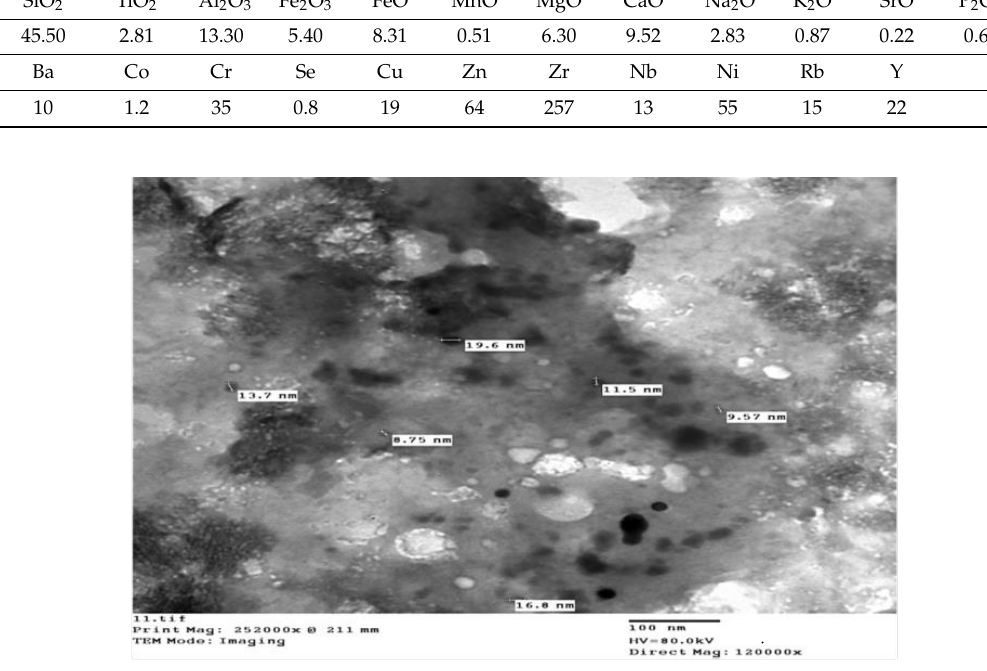
Figure 1. Zeolite nano-loaded nitrogen particles. Table 3. Chemical composition of n-ZEs after being loaded with nitrogen.